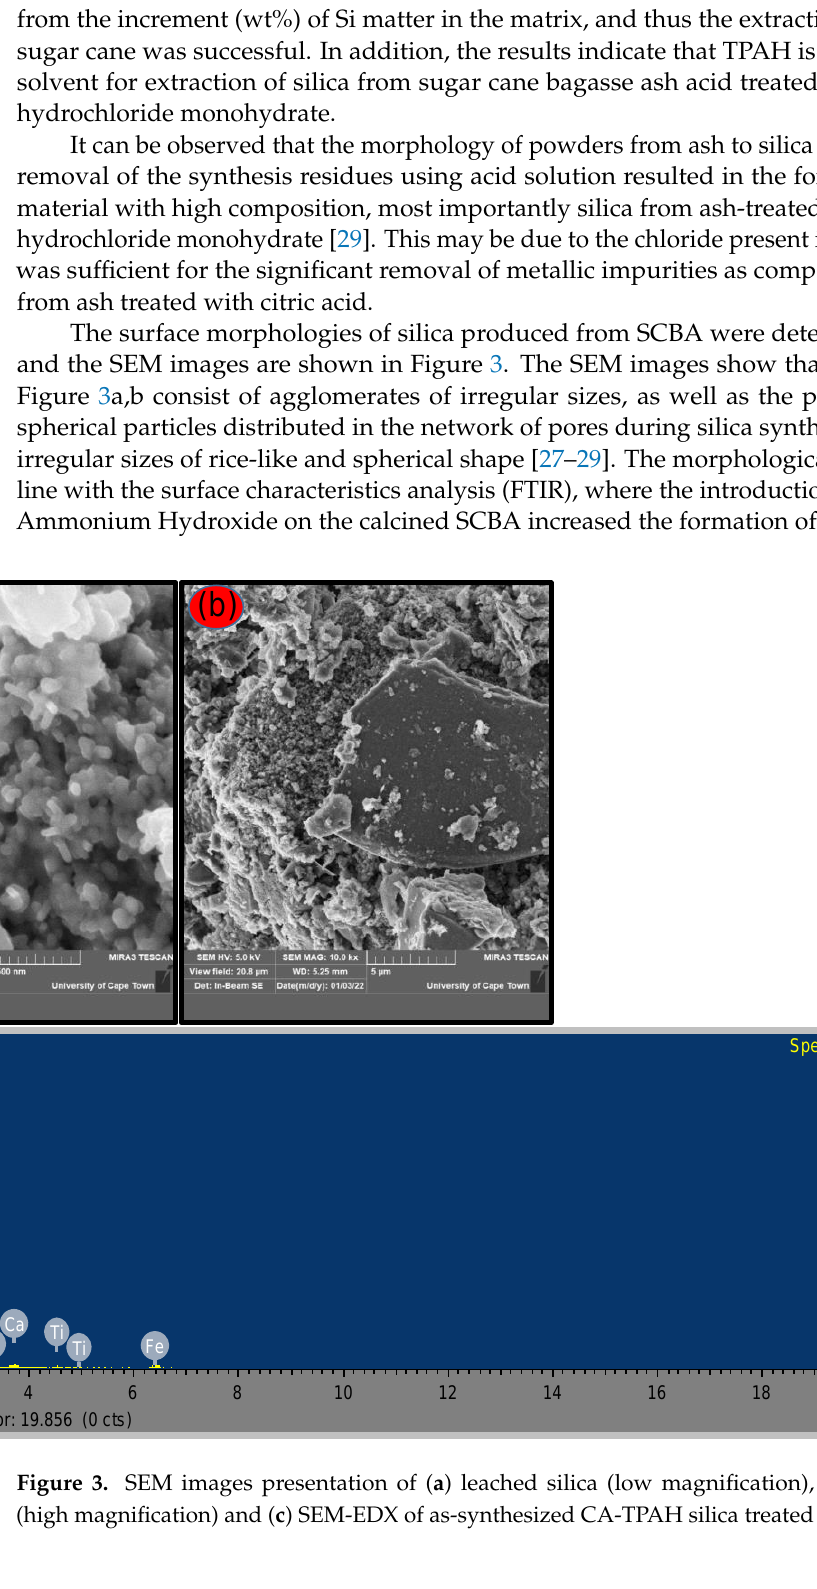
Table 1. Chemical analysis of sugarcane bagasse composition acid treated with citric acid (ca) and L-cysteine hydrochloride monohydrate (L-cys). Element